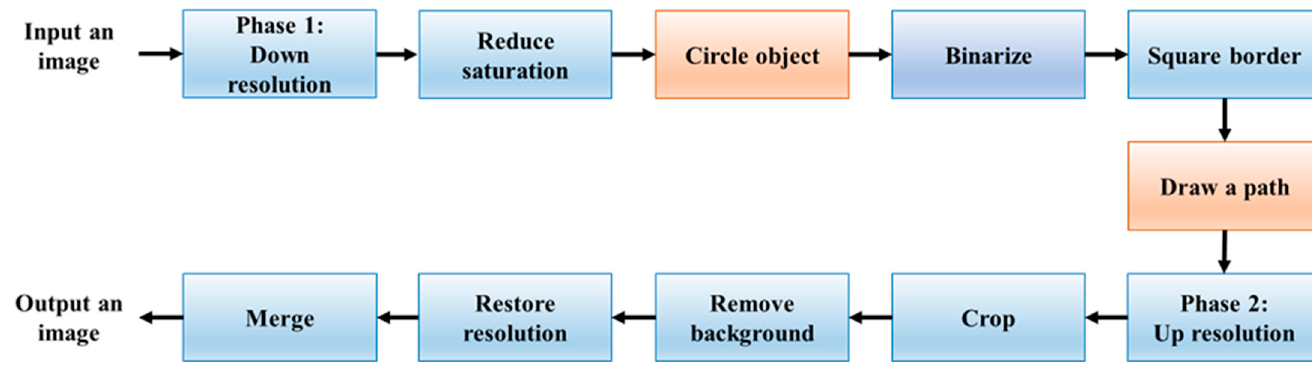
Figure 14. Execution flow.